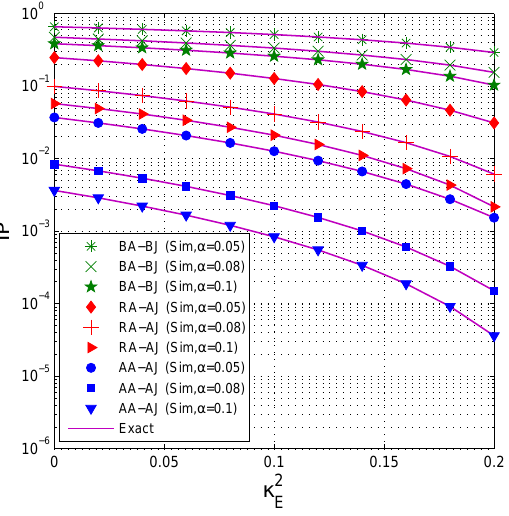
Figure 5. IP as a function of M when ∆ = 5 (dB), C N E = 3 , K = 3 , α = 0 . 1 and µ 2